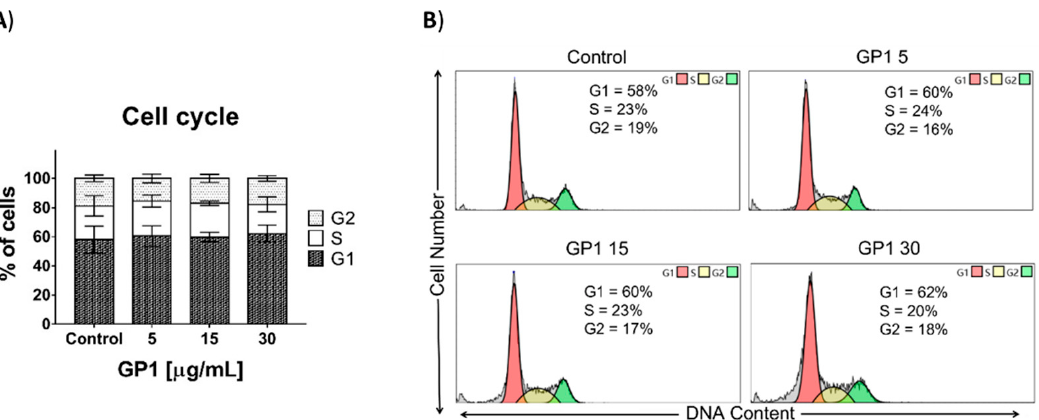
Figure 5. Analysis of cell cycle profile of A549 cells treated with GP1 for eight weeks as determined by flow cytometry. ( A ) Distribution of cell cycle phases (mean ± SD, n = 3). ( B ) Representative histograms of cell cycle analysis from one of three independent experiments. The percentage of individual cell cycle phases did not statistically differ between three independent experiments. Statistical significance was evaluated with Student’s t -test.